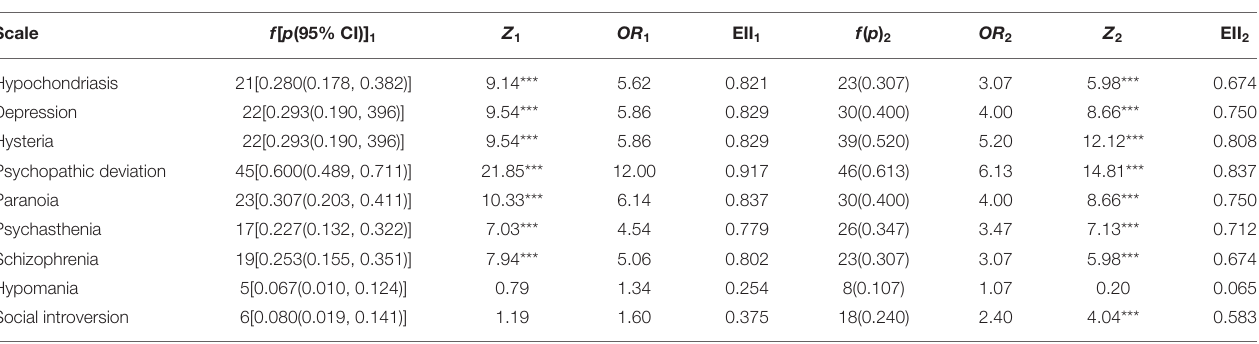
TABLE 3 | Caseness in the MMPI-A basic clinical scales among CPOs.